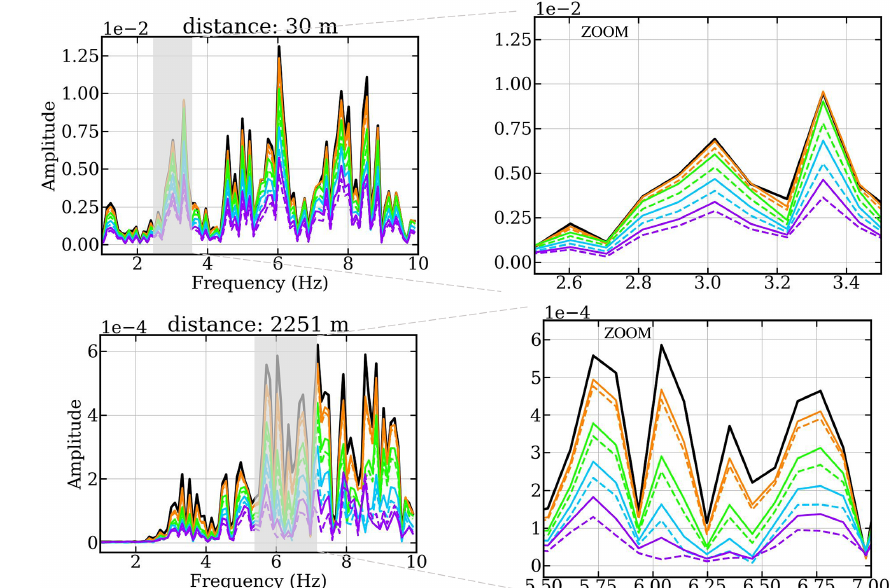
Figure 5. Frequency spectra of the simulation results for the seismic noise from the source time function from Neuffer et al. (2021) and in presence of half-circular trenches with varying dimensions compared with a model without trenches (black curve). See Fig. 3b for the models considered here and Fig. 4 for the legend of models depicted by the